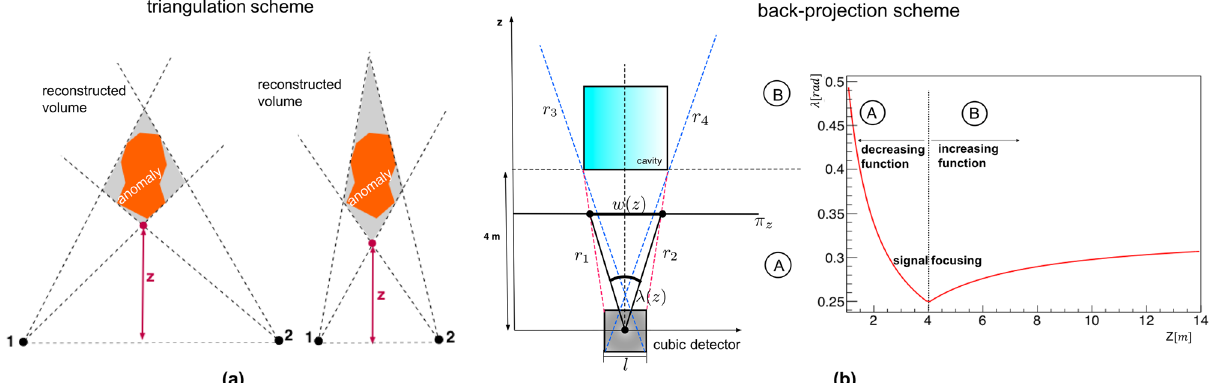
Figure 1. Schematic representation of the three-dimensional reconstruction methods: triangulation ( a ) and back-projection ( b ). In ( a ) the two sketches show the triangulation results of the same object assuming different measurement configurations; the resulting different elongated shapes reconstructed with this technique are shaded in gray. In ( b ) the operating principle of the back-projection technique is schematically represented. The angular size (cid:31) ( z ) of cavity seen from the center of the detector reaches its minimum on the plane of back- projection π z at the distance at which the base of the cavity is located. At this distance, the transverse linear dimension w ( z ) of the cavity on π z plane represents the true size. In the figure on the right the analitycal trend of the (cid:31) ( z ) function is